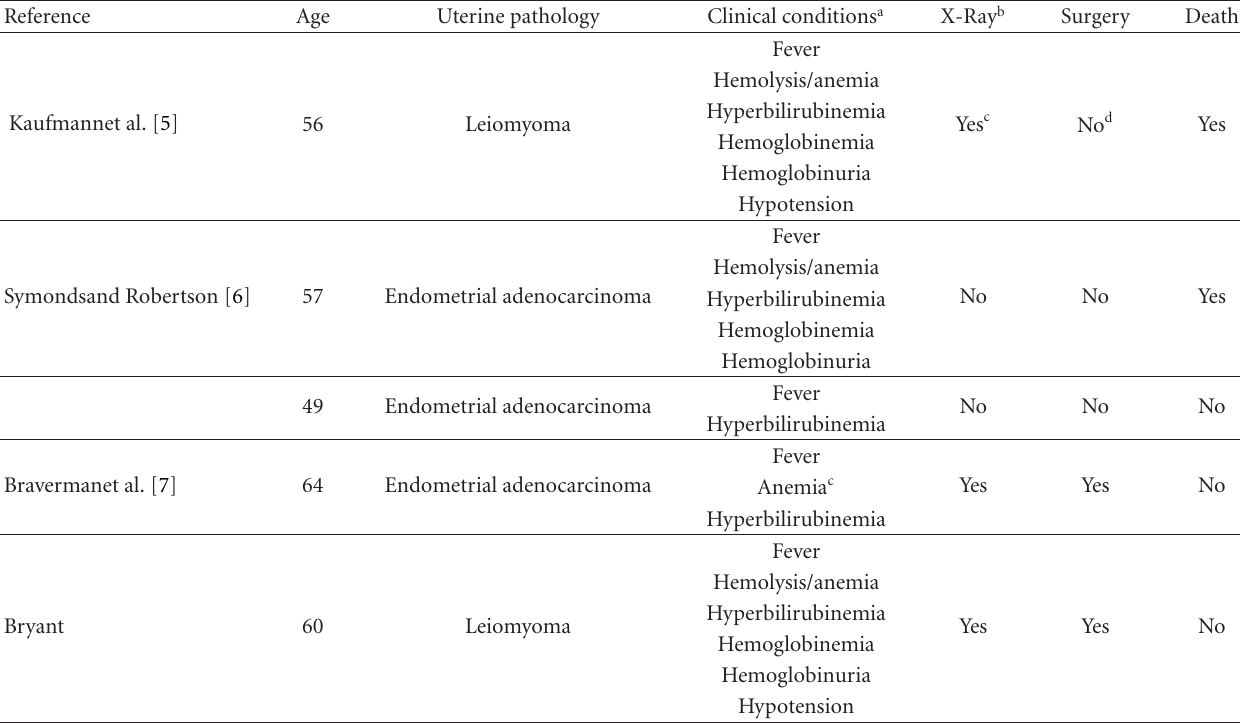
Table 1: Summary of cases of Clostridium perfringens in middle-aged (age > 45 years)